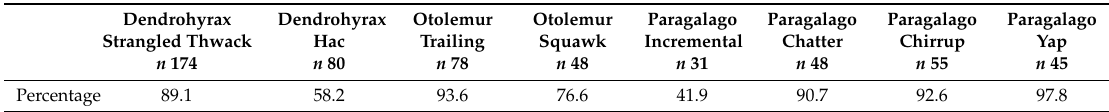
Table 1. Multinomial linear regression (MLR) results in di ff erent calls. MLR categorized 82.8% of the calls correctly using the covariates call duration, maximum frequency, and maximum